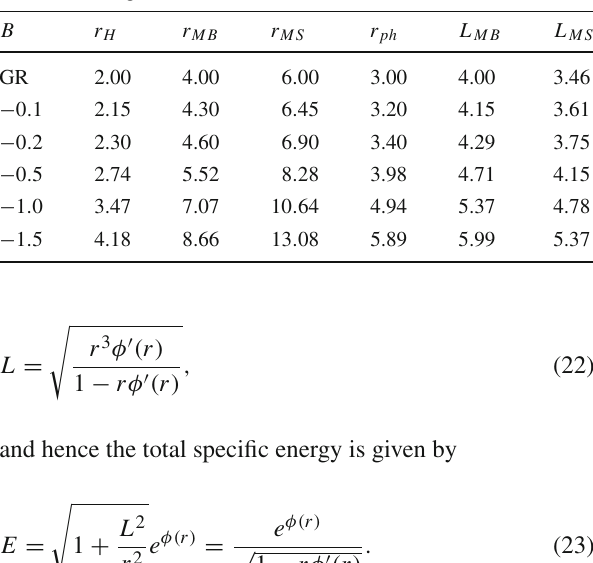
Table1 Variousparametersofspacetimefordifferentvaluesof B : r H is the event horizon, r MB the marginally bound orbit, r MS the marginally stable orbit, L MB and L MS are their corresponding specific angular momentaand r ph isthephotonorbit.Allthevaluesareindimensionless unit considering c = G = M =